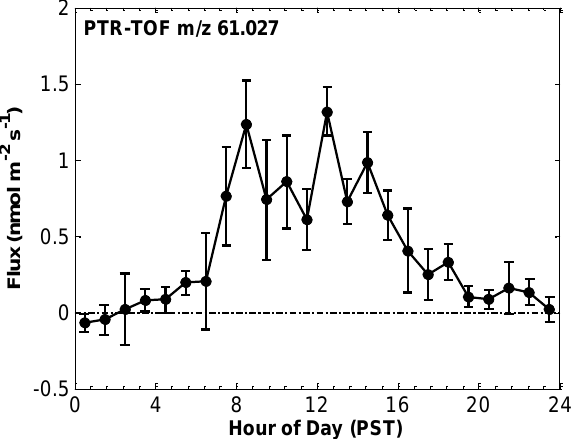
Fig. 12. Total and fractional BVOC diurnal flux measured by PTR-TOF-MS on a carbon mass basis. Staged bar plots of 27 masses with the largest fluxes are shown throughout the day with m/z indicated in the legend.